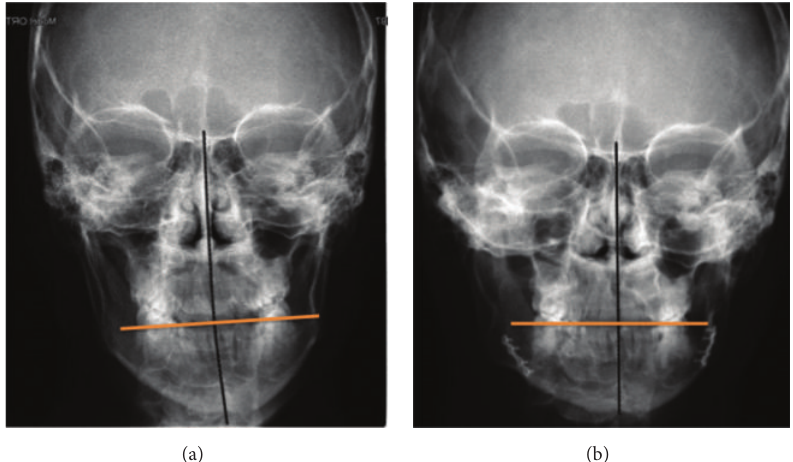
Figure 16: Comparison of the skull teleradiography in a posteroanterior projection before the treatment (a) and at the 6-year follow-up evaluation